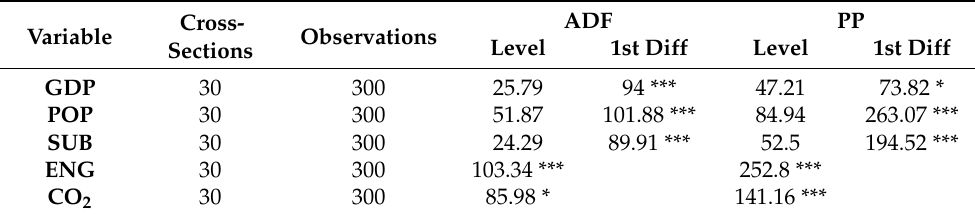
Table 3. Unit root test